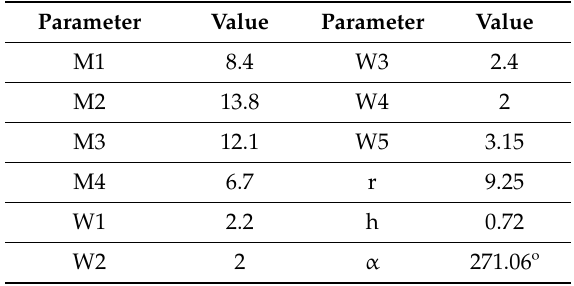
Table 2. Final design parameters of the proposed quasi-isotropic antenna